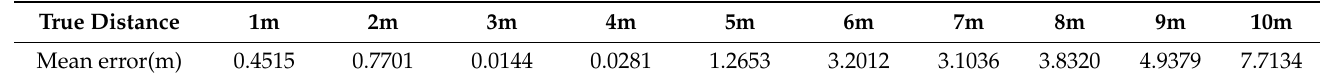
Figure 6. Estimated distance mean error graph of reverse tangent-based scheme . Table 1. Estimated distance mean error of reverse tangent-based scheme .